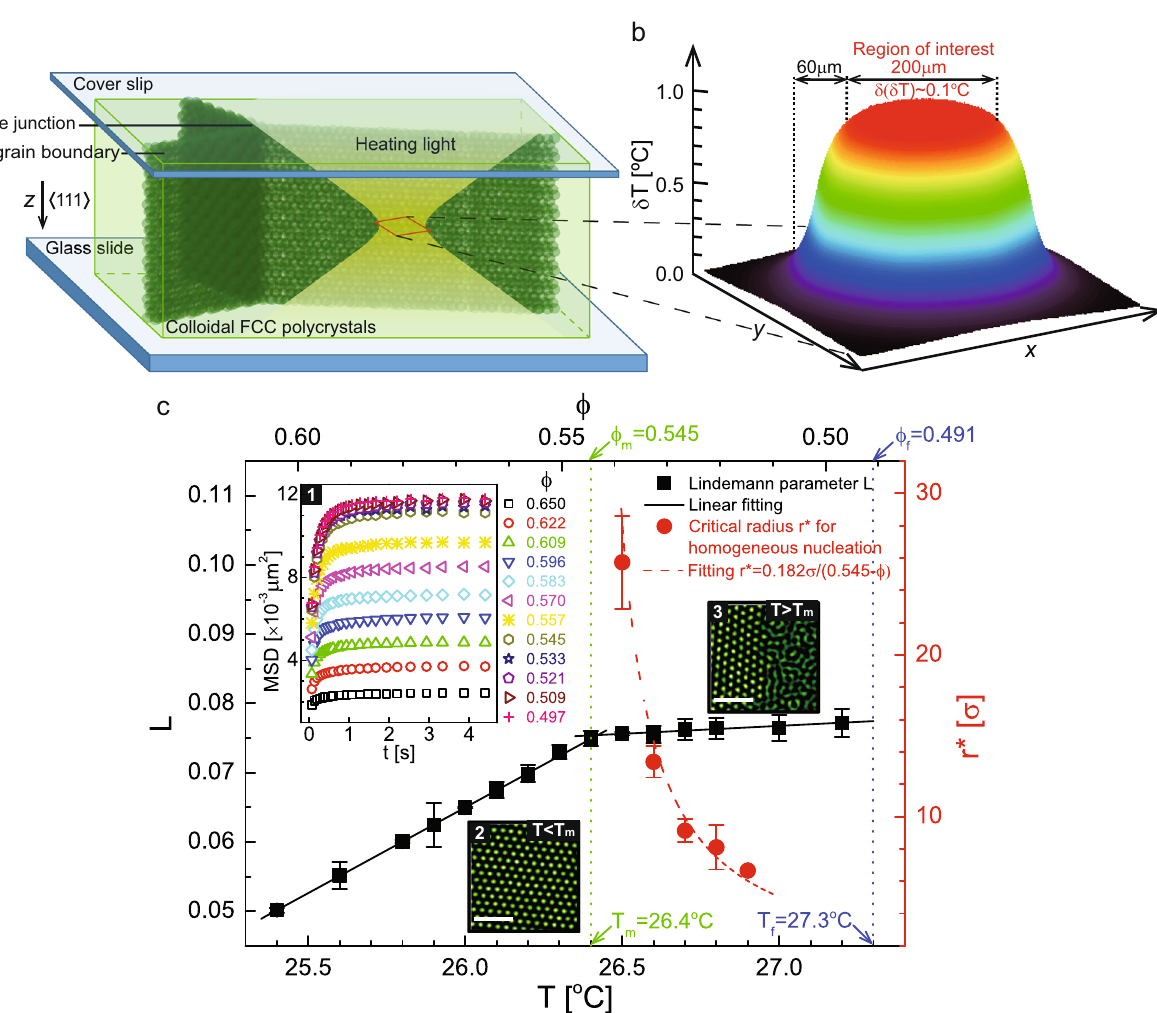
Fig. 1 The optical heating and determination of the melting point. a The schematic of optical heating. b The measured temperature pro fi le on the object plane. c Determination of the bulk melting point. Squares: Lindemann parameter L as a function of temperature (and volume fraction ϕ ). Circles: the critical radii for homogeneous nucleation inside a superheated single crystalline domain. The vertical dotted lines denote the melting and freezing points respectively. Inset 1: 2D mean-square displacement (MSD) which saturates after 4 s. L is computed from the MSD plateau value. Insets 2 and 3: cross- sections of real images of the crystals and the bulk solid – liquid coexistence before and after melting, respectively. Error bars correspond to the standard deviation. Scale bars: 5 μ